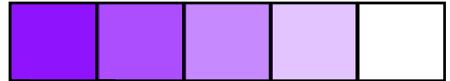
FIG. 2. Example of deliberate practice to develop a critical thinking skill (case IV). Shading represents the amount of available agency for practicing the critical thinking skill; lighter color means more agency available to groups. Each box represents lab in- structions for a single lab activity and time goes from left to